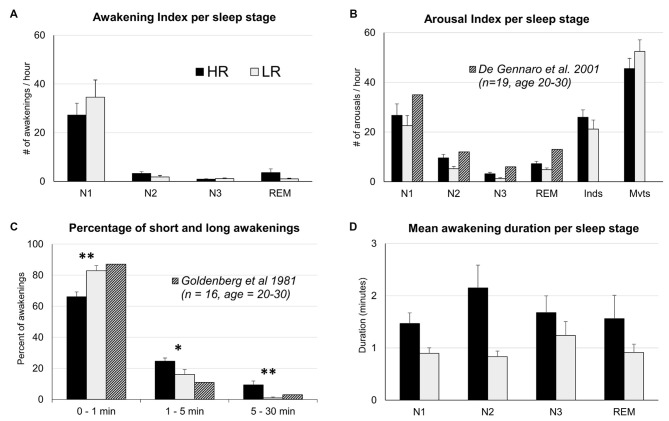
Means and SEM of sleep parameters for High and Low dream recallers (HR and LR). (A) Awakening index per sleep stage (number of awakenings per hour in each sleep stage). (B) Arousal index (AI) per sleep stage (number of arousals per hour in each sleep stage). (C) Percentage of short and long awakenings. (D) Mean duration of awakenings per sleep stages. Hatched columns represent standards values. *p < 0.05, **p < 0.01.